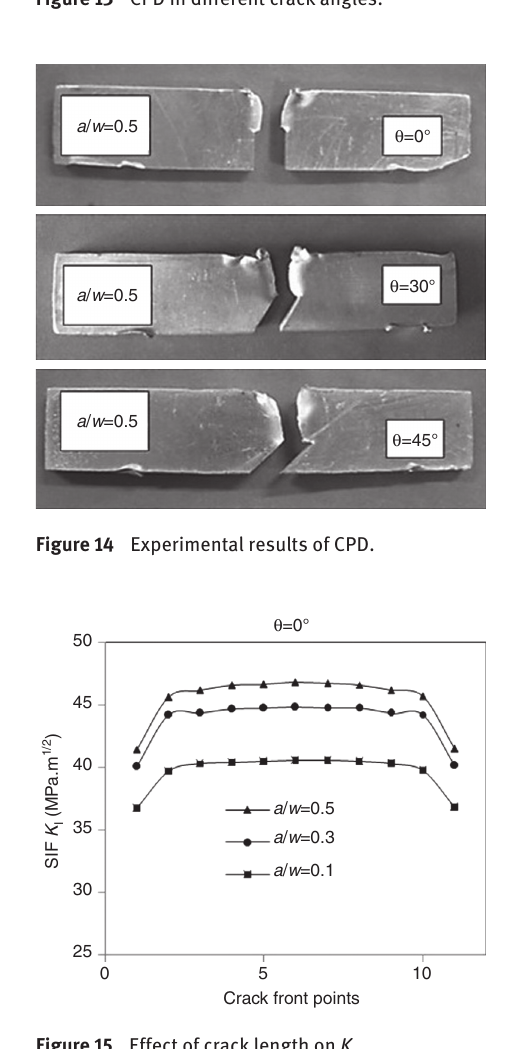
Figure 15 Effect of crack length on K